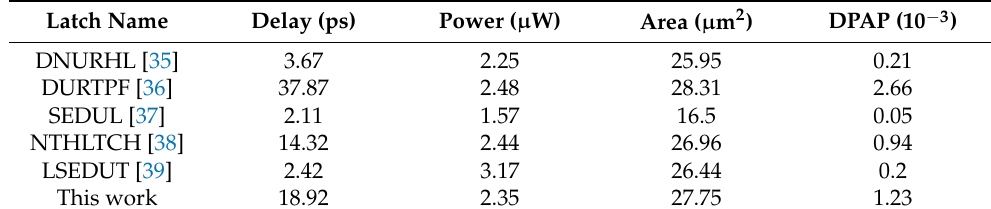
Table 2. Cost comparison of the proposed DNURF with existing hardened latches.